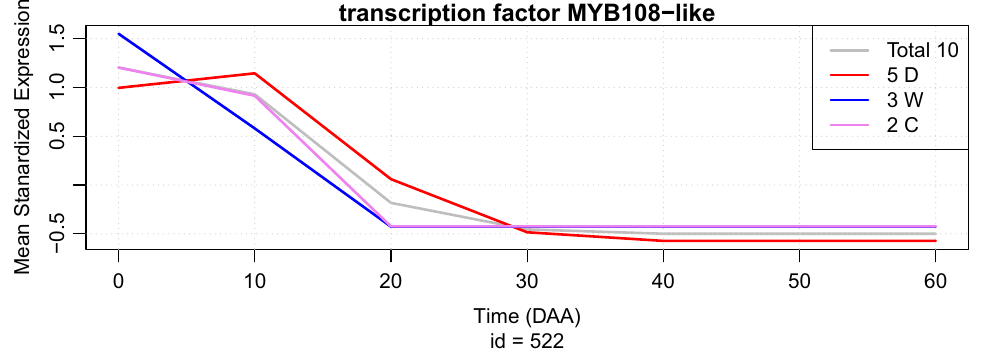
Figure 4. Result of running “ gene.summary(temp1$id[1]) ” (see